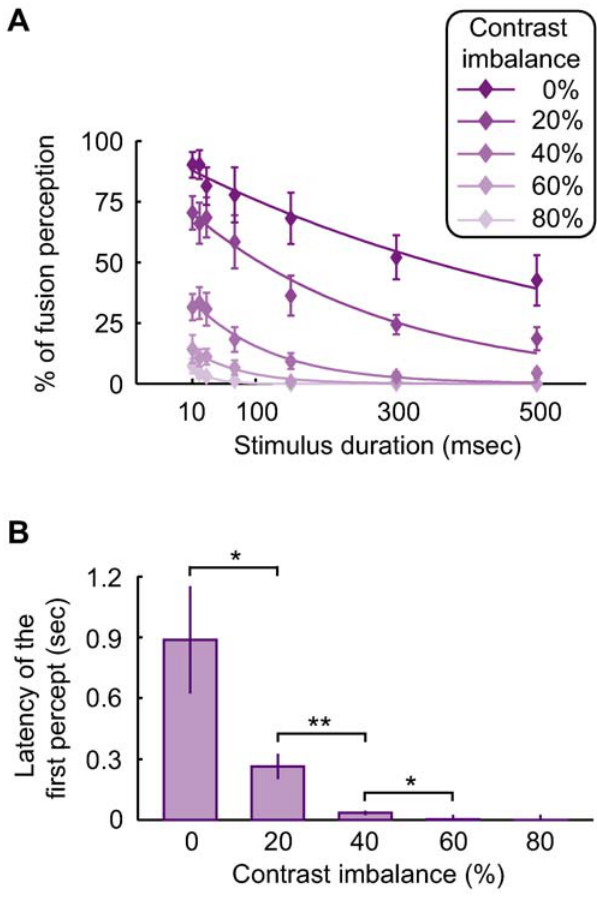
Figure 3. Influence of contrast imbalance on the latency of the first percept. (A) For each contrast imbalance, the latency of the first percept was quantified as the stimulus duration that corresponded to 33% of fusion perception. Error bars represent 1 SEM (n=7). (B) The latency of the first percept shortens as the contrast imbalance increases from 0% to 20% (*, Wilcoxon rank-sum test, p , 0.05), from 20% to 40% (**, Wilcoxon rank-sum test, p , 0.02), and from 40% to 60% (*, Wilcoxon rank-sum test, p , 0.05). Error bars represent 1 SEM